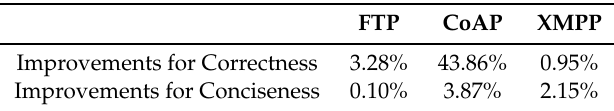
Table 1. Improvements for